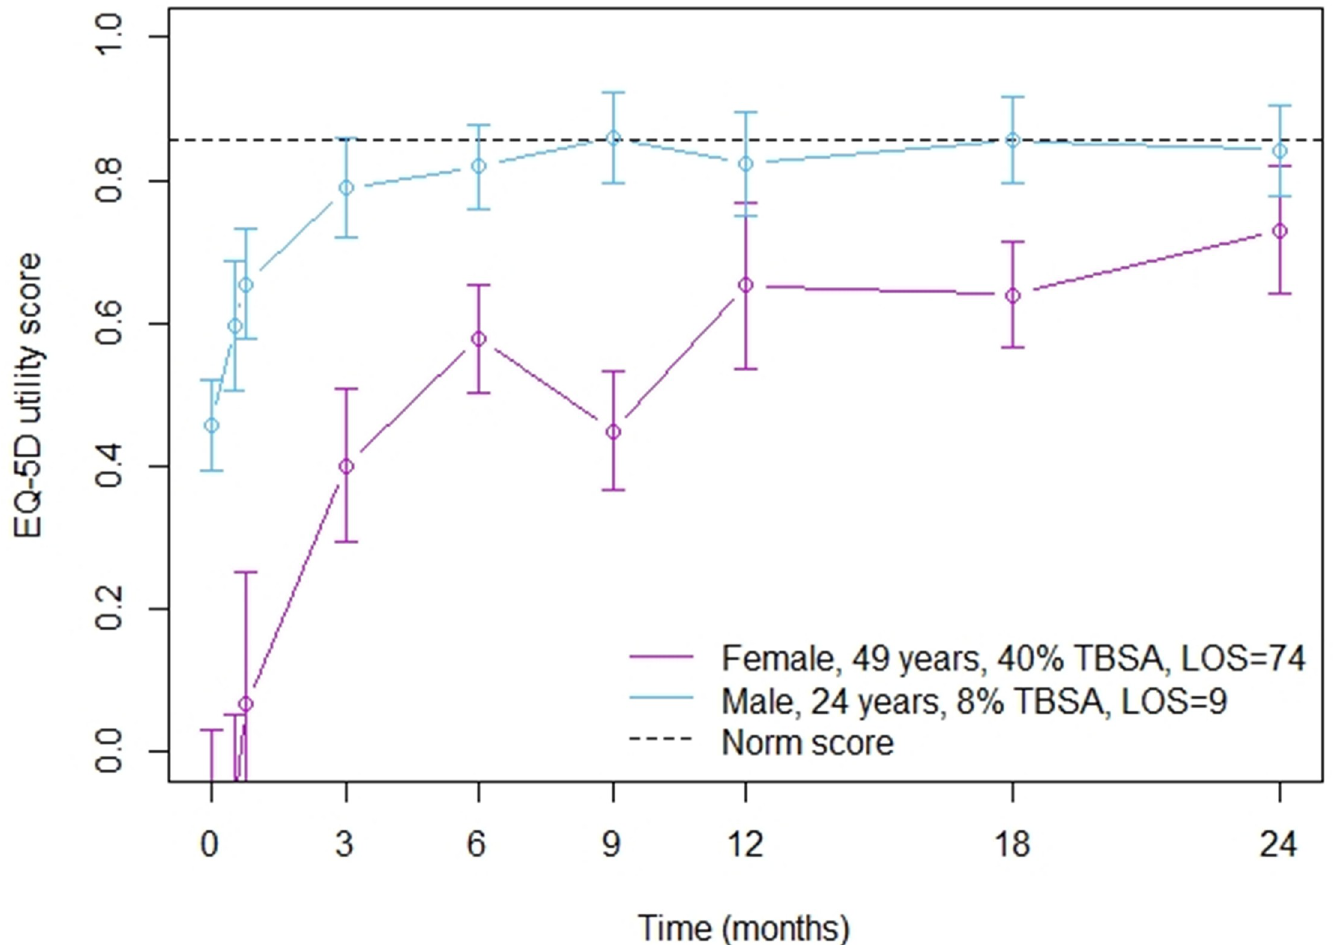
Fig 6. Example of estimated recovery of HRQL for two specific patients. This figure shows the estimated EQ-5D utility recovery for 1) a female, aged 49 years old, 40% TBSA and length of hospital stay (LOS) of 74 days, and 2) a male, aged 24 years old, 8% TBSA and LOS 9 days.